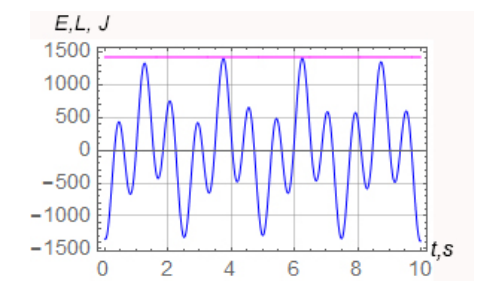
Figure 8. Graph of kinetic and potential energy versus time: T [ t ] – purple, P [ t ] – blue